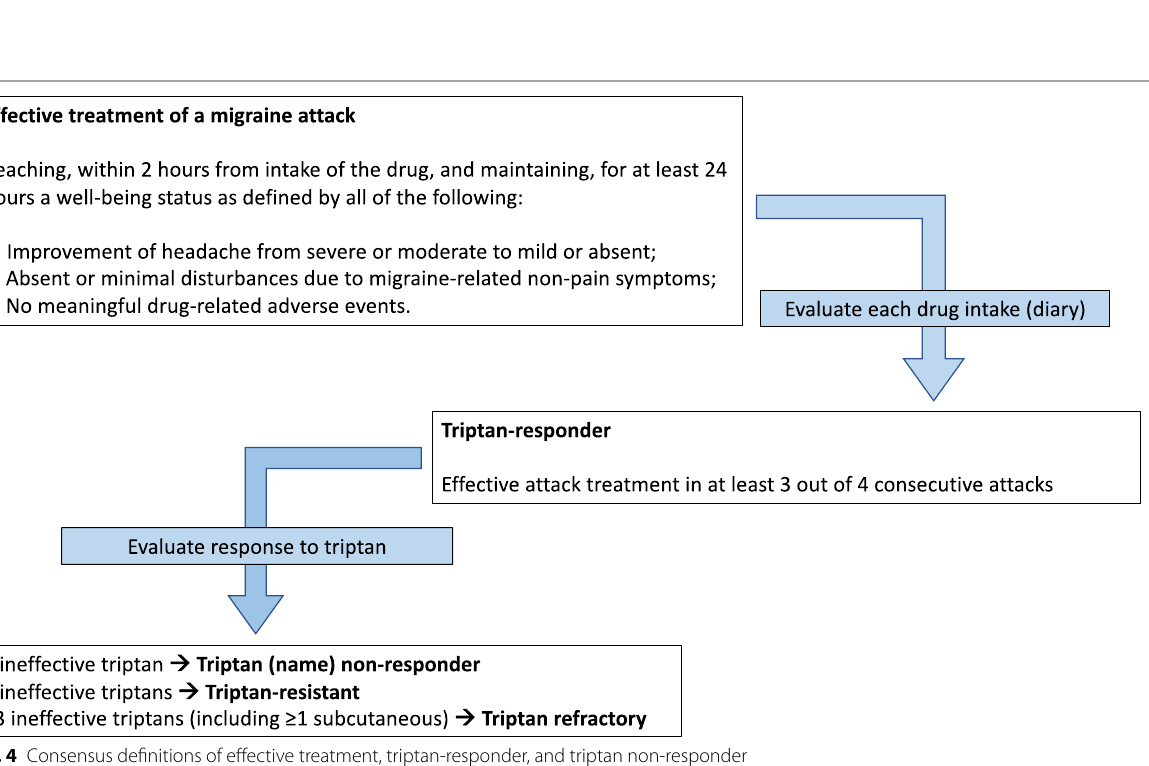
Fig. 4 Consensus definitions of effective treatment, triptan‑responder, and triptan